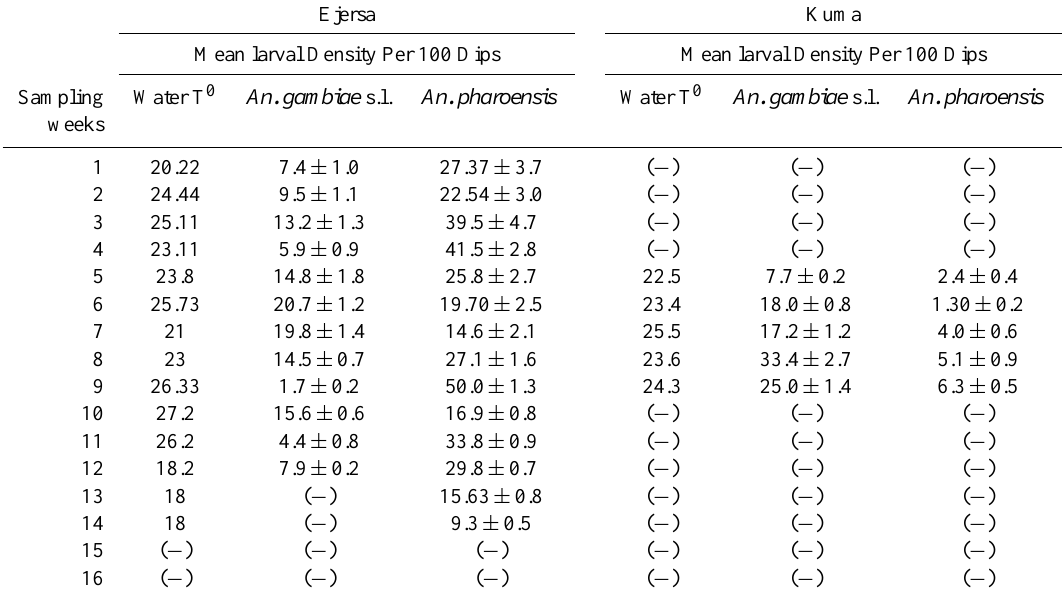
Table 3. Mean water temperatures and larval density of An. gambiae s.l. and An. pharoensis in different sampling interval during the study period (August–December